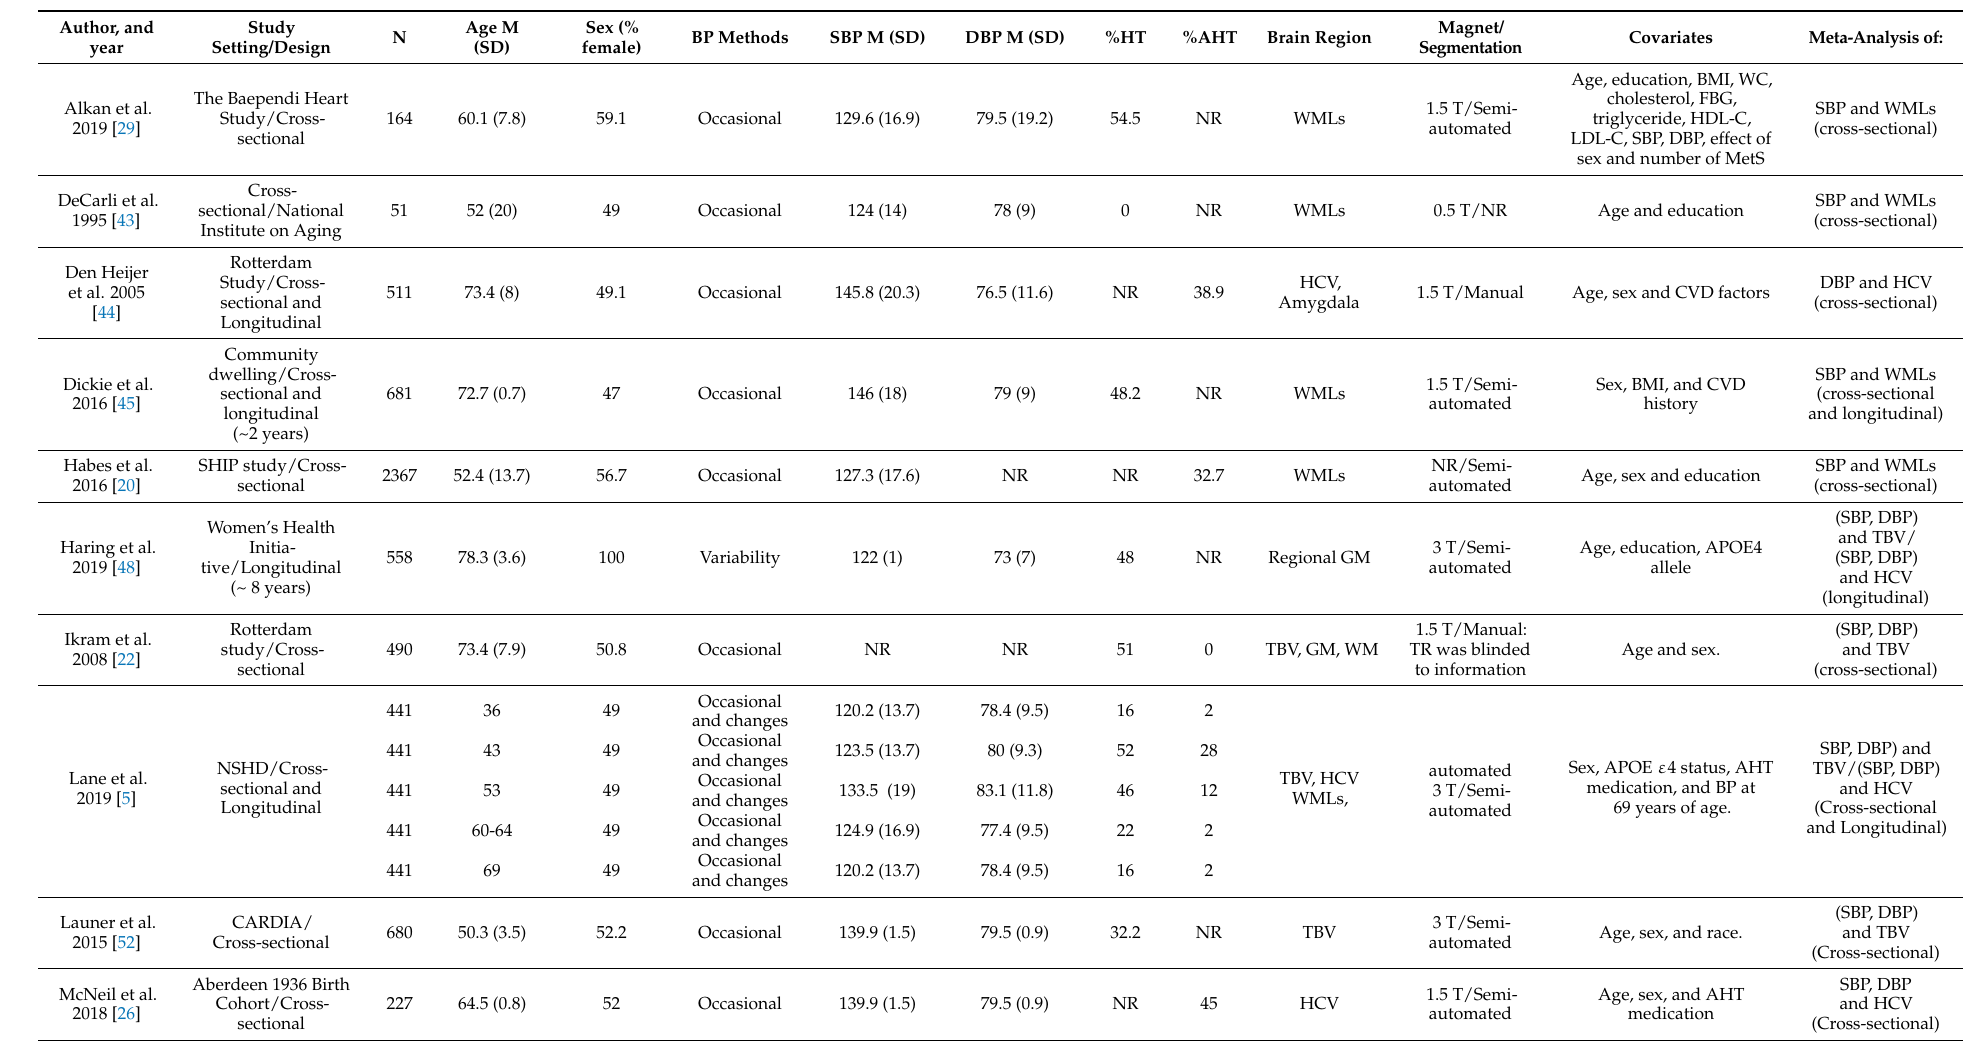
Table 1. Characteristics all included studies which contributed to the meta-analysis ( n =